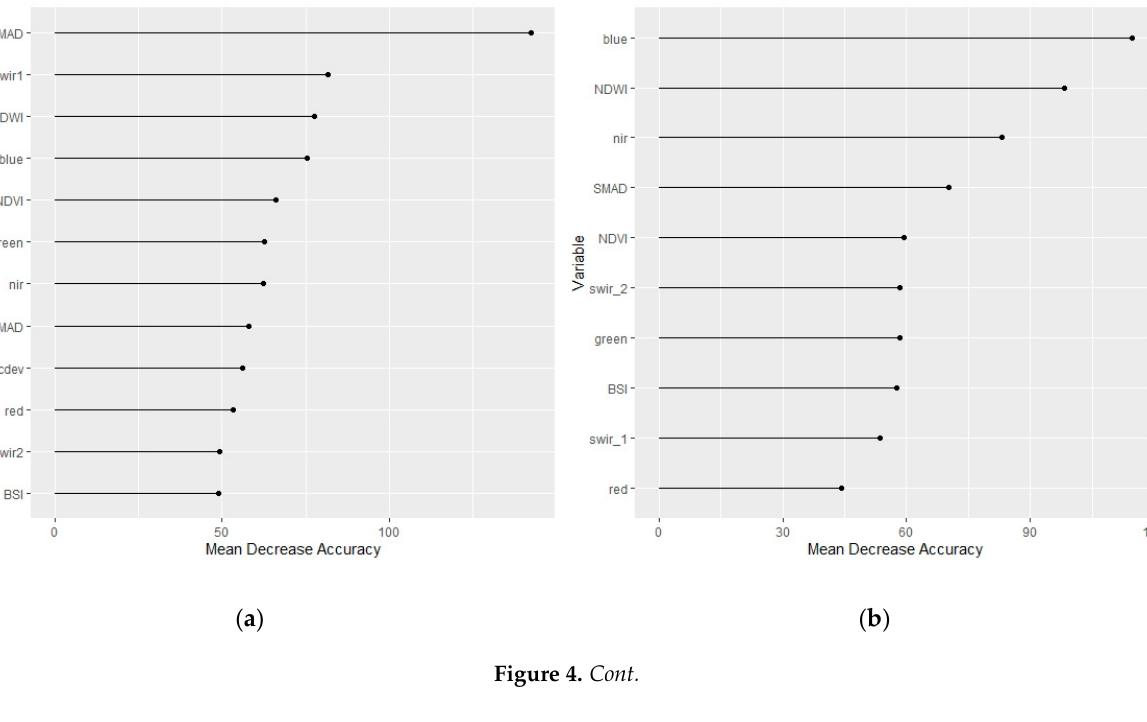
( d ) Figure 4. Variable importance expressed as mean decrease in accuracy for the random forest classification models on annual datasets, shown in Figure 3, for ( a ) Ord River Irrigation Area, ( b ) Silalatshani, ( c ) Nabusenga, and ( d ) Lungwalala. Figure 5 shows the variable importance plots for the stacked quarterly (4 geomedian images x 10 predictors described in Table 2 = 40 predictors) classification datasets. The SMAD variable for each quarter appeared in the top 15 most important variables of 40 for each site. Like the annual datasets, the importance of indices and spectral bands varied between sites. There was no discernible trend for the importance of specific quarters in any classification model (Figure 5).